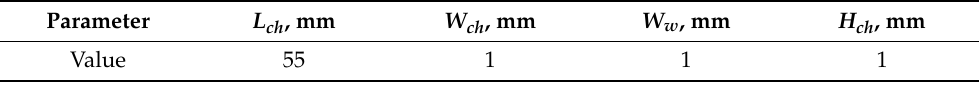
Figure 1. Microfluidic heat exchanger (MFHE) top view ( a ), side view with the thermocouples location ( b ), cross-section of MFHE ( c ). All dimensions are in millimeters. Table 1. Geometrical dimensions of